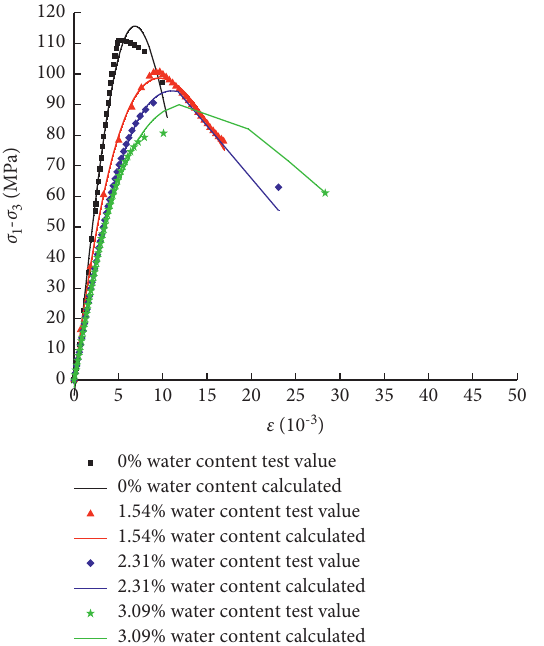
Figure 12: Theoretical and experimental curves under different water contents in